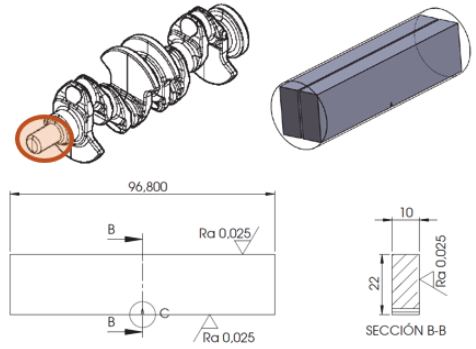
Figure 3: Extraction location and geometry of the specimens used in the crack growth tests.